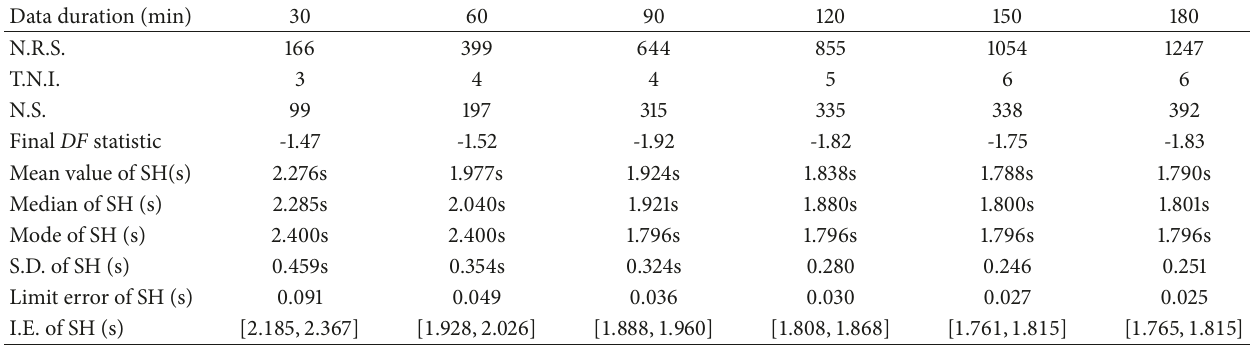
Table 7: SFR estimations of lane 2 under different data